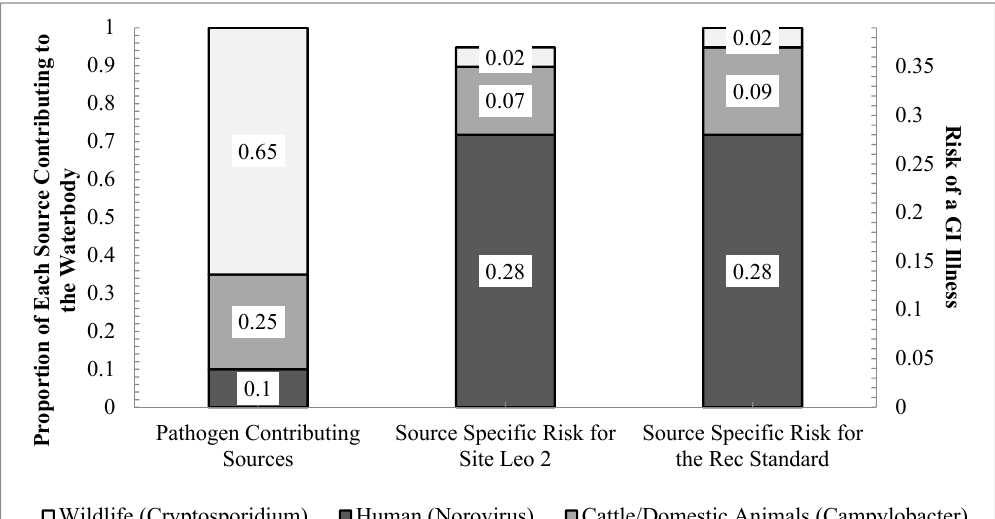
Figure 2. Contribution of each source to the health risk under Scenario 2 (each source contributes according to the microbial source tracking (MST) results). LEO 2 had an E. coli concentration of 163 cfu 100 mL − 1 and the recreational standard had an E. coli concentration of 126 cfu 100 mL − 1